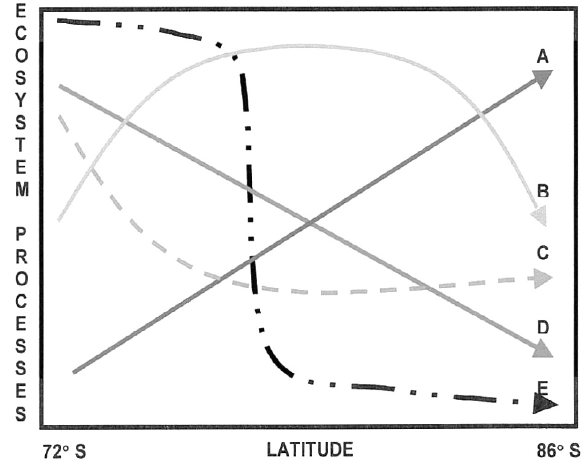
(Table 1) across the latitudinal gradient of Victoria Land, Antarcti- ca: A and D (linear ecosystem changes associated with environ- mental phenomena such as solar radiation and photo-periods); and B, C and E (non-linear ecosystem changes associated with envi- ronmental phenomena such as the number of freeze-thaw cycles and ice-tongue thresholds). From Berkman and Everett